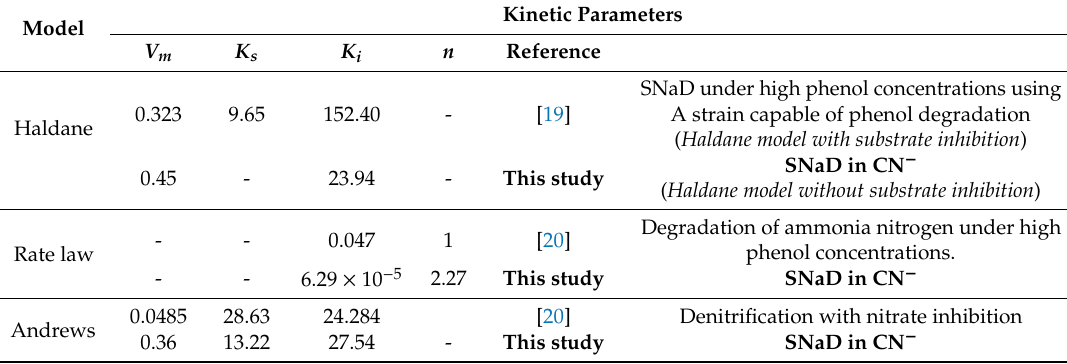
Kinetic parameters obtained from di ff erent studies assessing nitrification and aerobic